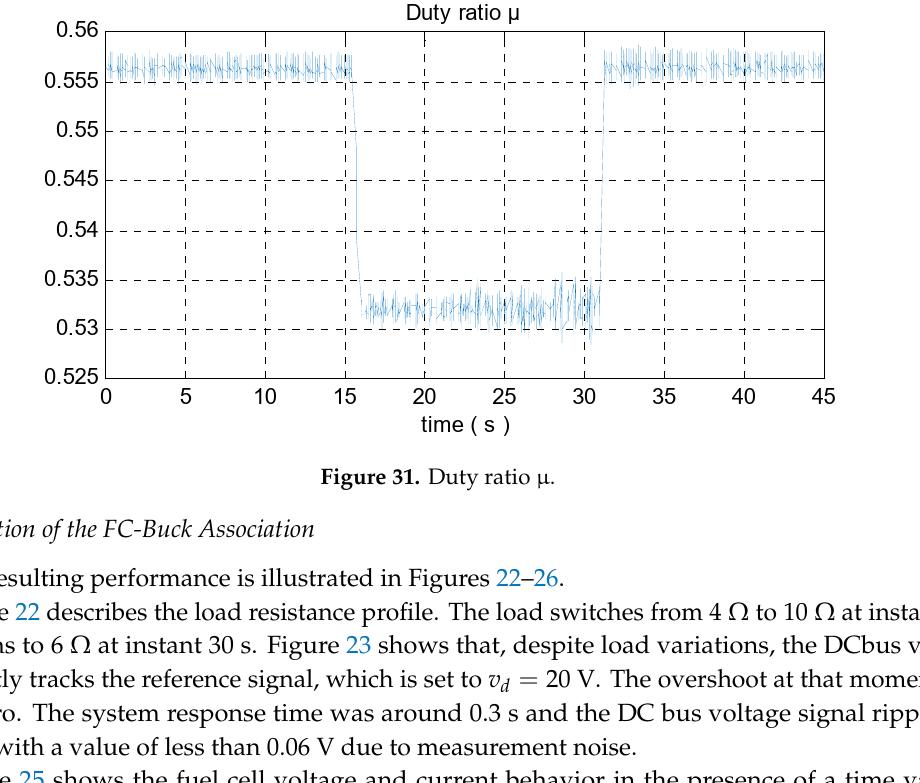
Figure 30. Fuel cell voltage